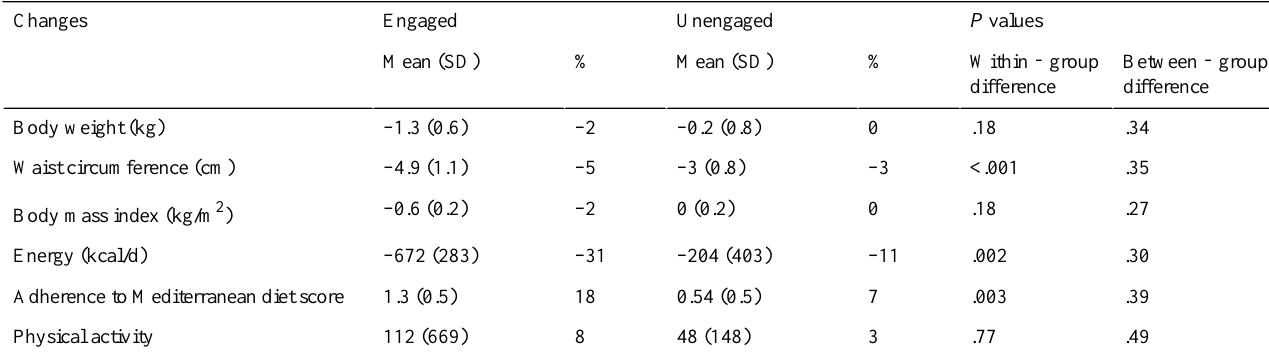
P valuesUnengagedEngagedChanges